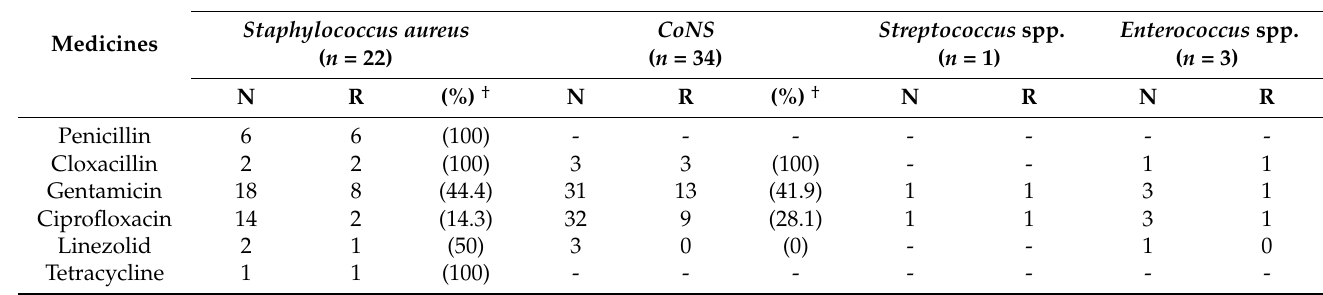
Table 7. Antimicrobial resistance patterns of Gram-positive isolates among neonates admitted with suspected sepsis at Komfo Anokye Teaching Hospital, Ghana, between January 2021 and December 2021.